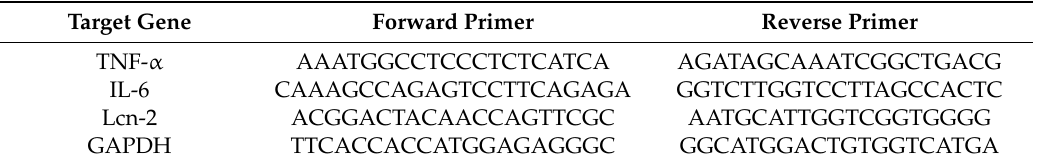
Table 3. Applied primer sequences for